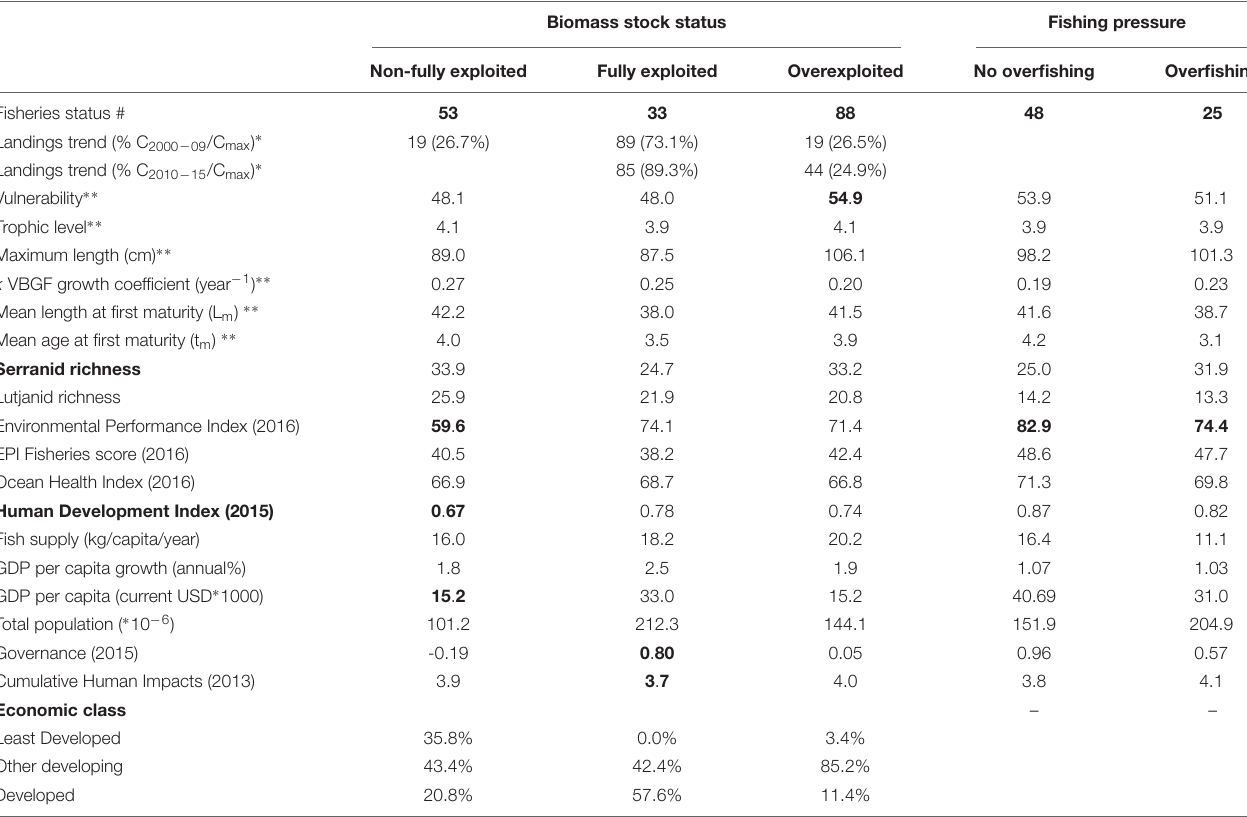
TABLE 4 | Summary of the statuses of snapper and grouper fisheries (biomass stock status and fishing pressure categories), FAO landings data trend classification (2000–2009 and 2010–2015), and exploitation status (% landings by decade versus landings of the decade with the highest value of landings, C max ), and average values of each variable calculated by biomass stock status category (non-fully exploited, fully exploited, and overexploited), considering the snapper and grouper fisheries compiled in this